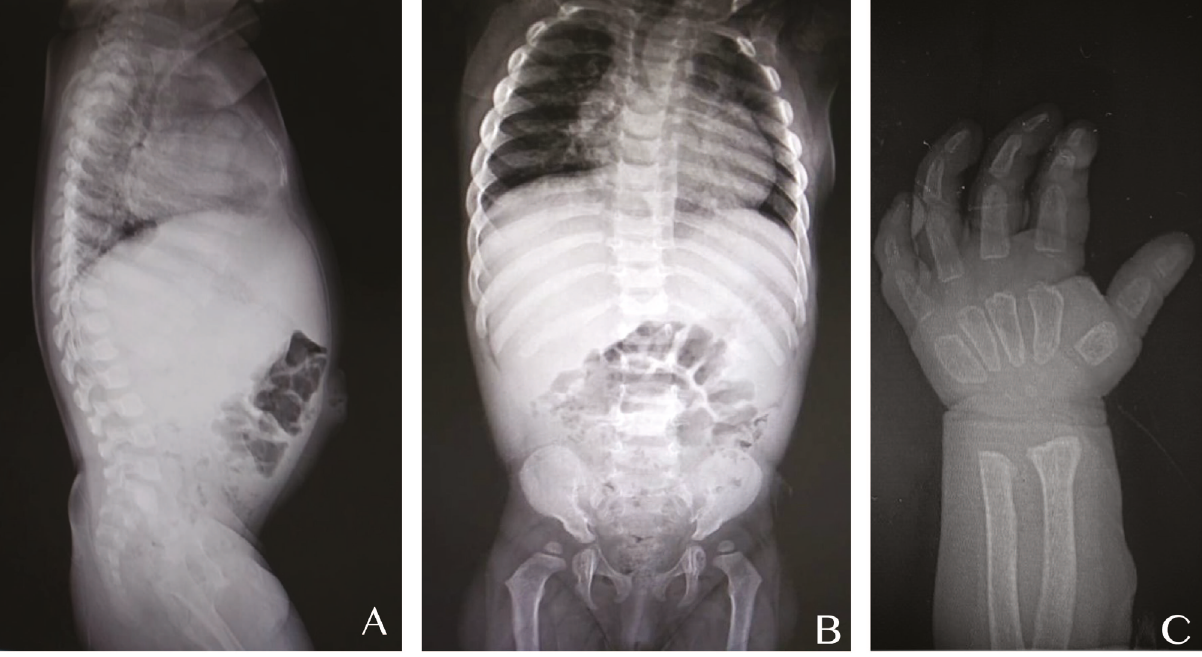
Figure 2. Radiological findings in a Hurler Syndrome patient. (A) Lateral view of the spine. Thoracolumbar kyphosis (B) Barrel-shaped chest. Hepatosplenomegaly. (C) Short hands with clawed